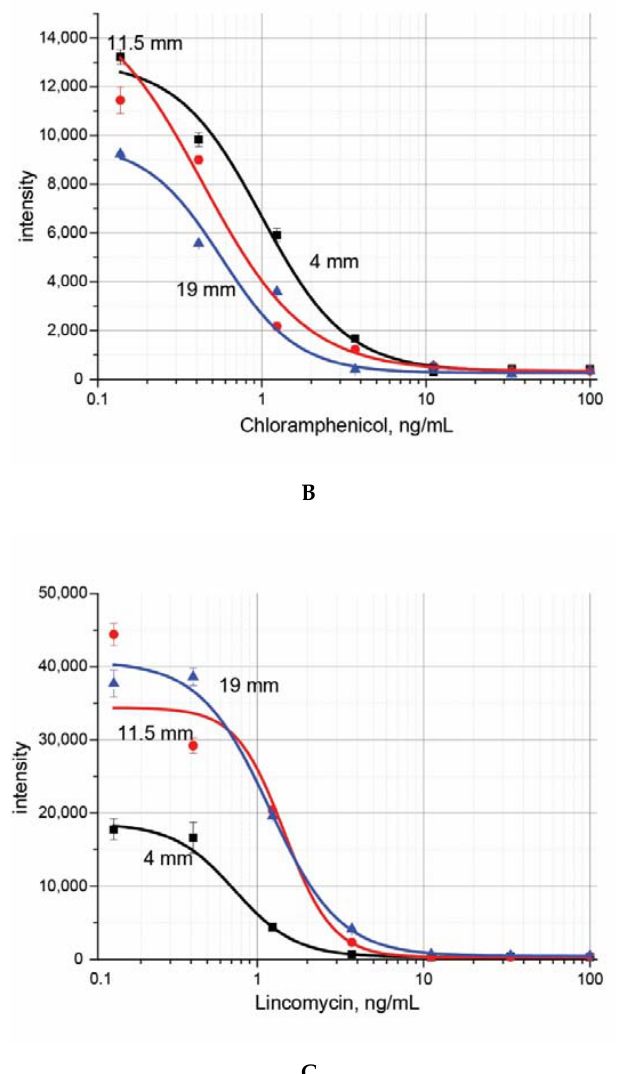
Figure 2. Calibration curves for monoplex lateral flow immunoassays of tetracycline ( A ), chloramphenicol ( B ), and lincomycin ( C ) for different location of test zones, n = 3.